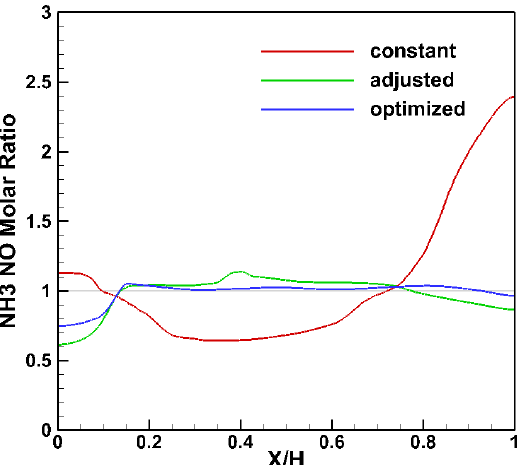
Figure 17. Comparison of NH 3 /NO ratio at the inlet of the catalyst layer for the lower-skewed profile.